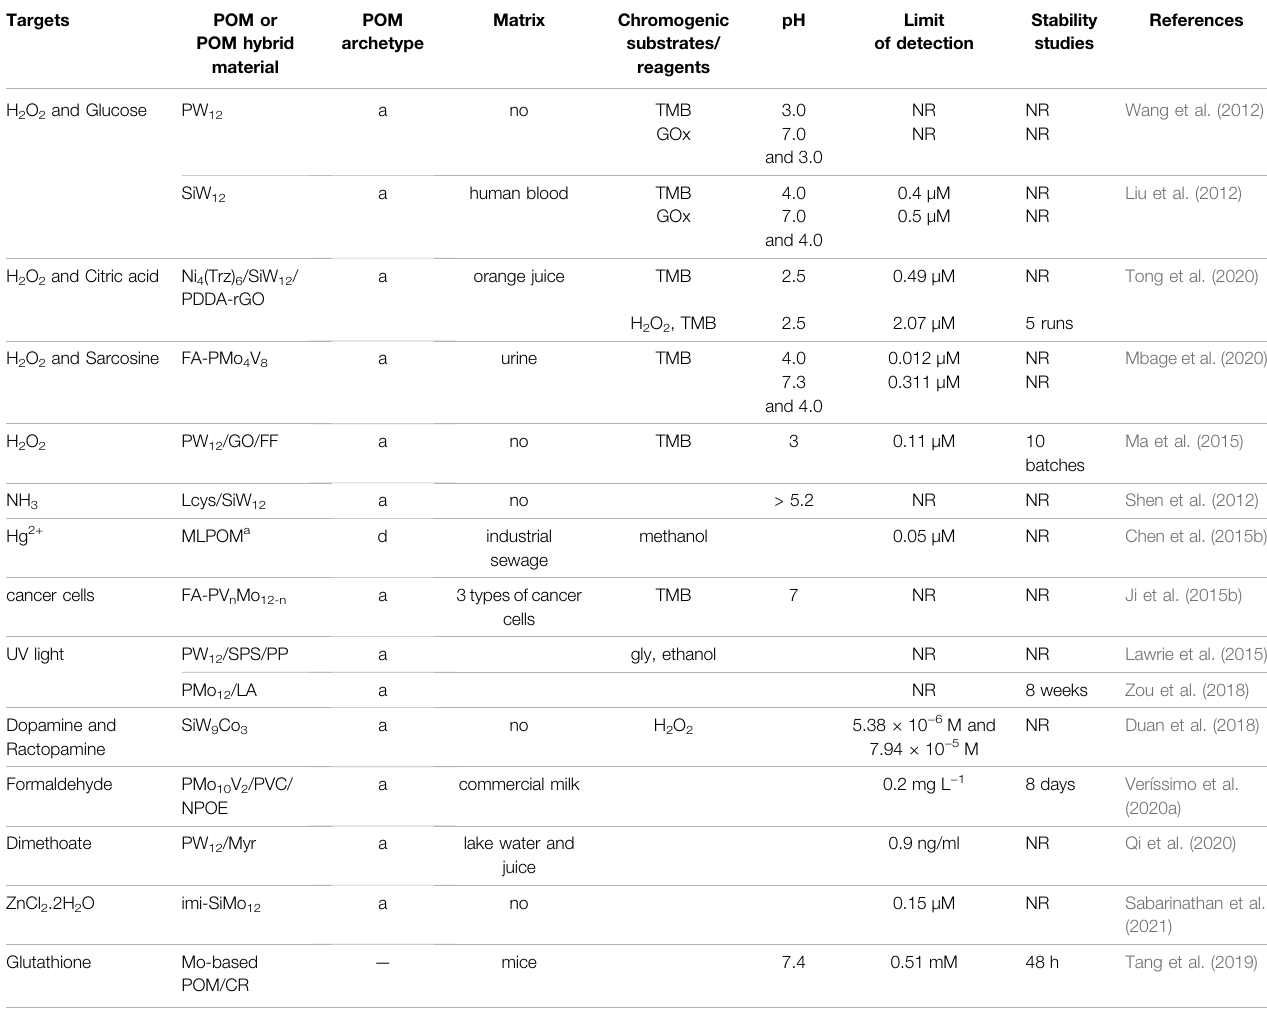
TABLE 7 | POM-based absorption optical sensors.